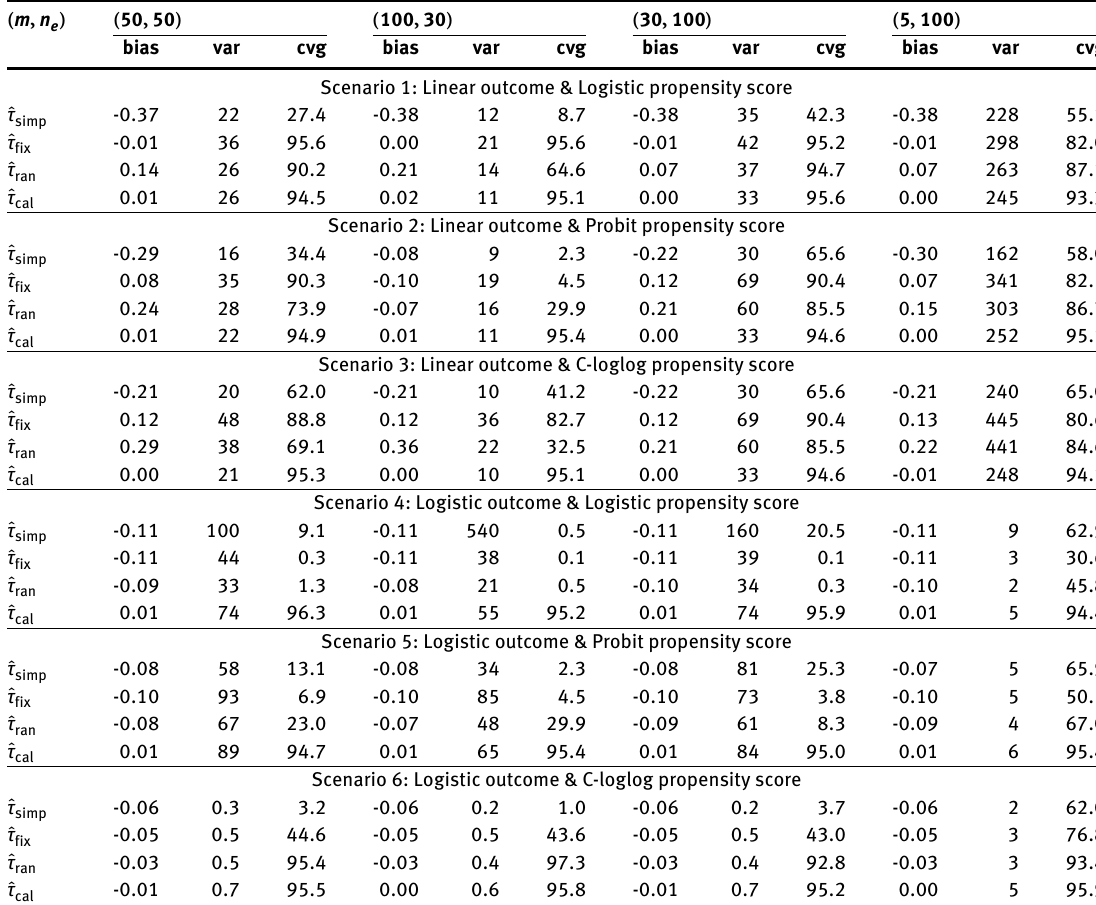
Table 1: Simulation results: bias, variance ( × 10 − 3 ) and coverage (%) of 95% confidence intervals based on 1 , 000 Monte Carlo samples; the outcome is linear and logistic linear mixed effects model and the propensity score is logistic, probit or comple- mentary log-log